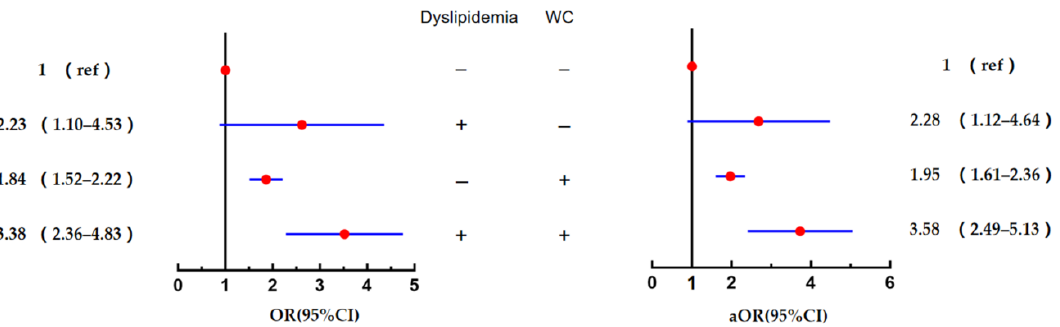
Figure 5. Combined effects of abdominal obesity and dyslipidaemia on diabetes. Note: Data presented with outcome, OR and 95% CI; aOR, adjusted odd ratio (adjusted variables were age, smoking status and hypertension).